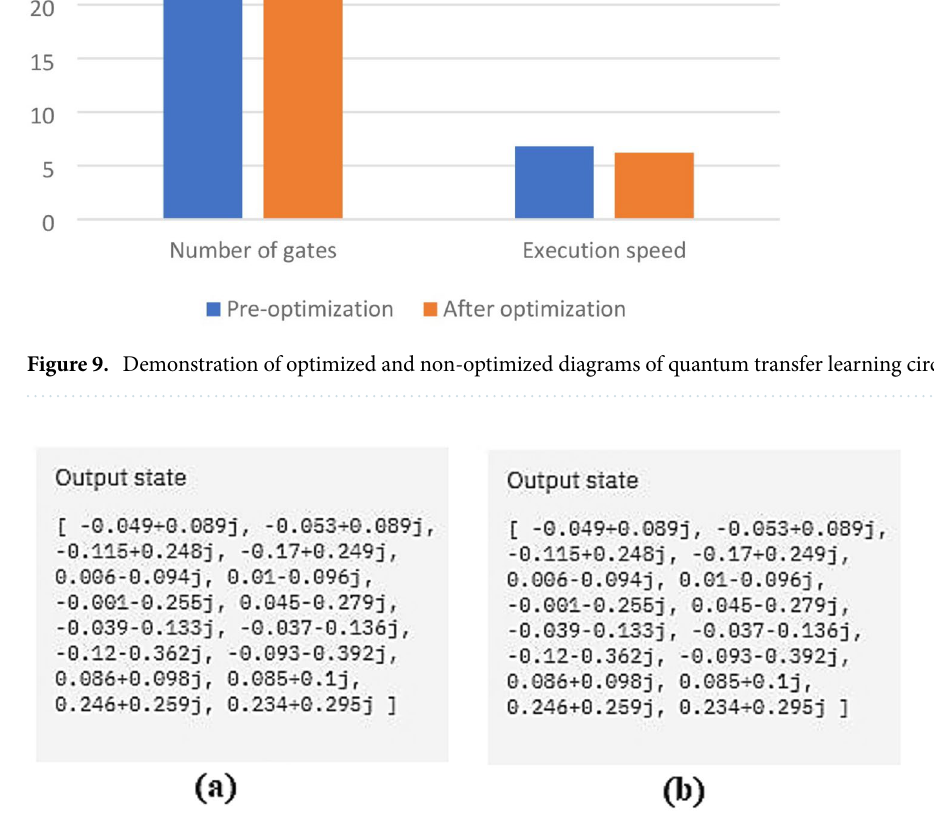
Figure 10. The simulation result of the output of the quantum transfer learning circuit before and after optimization in ( a ) and ( b ), respectively. The results are